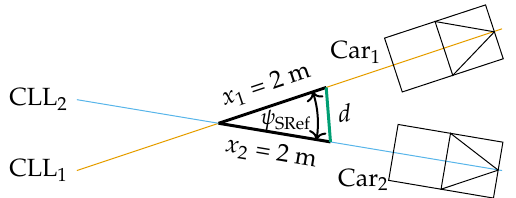
Figure 4. Measurement setup for yaw angle